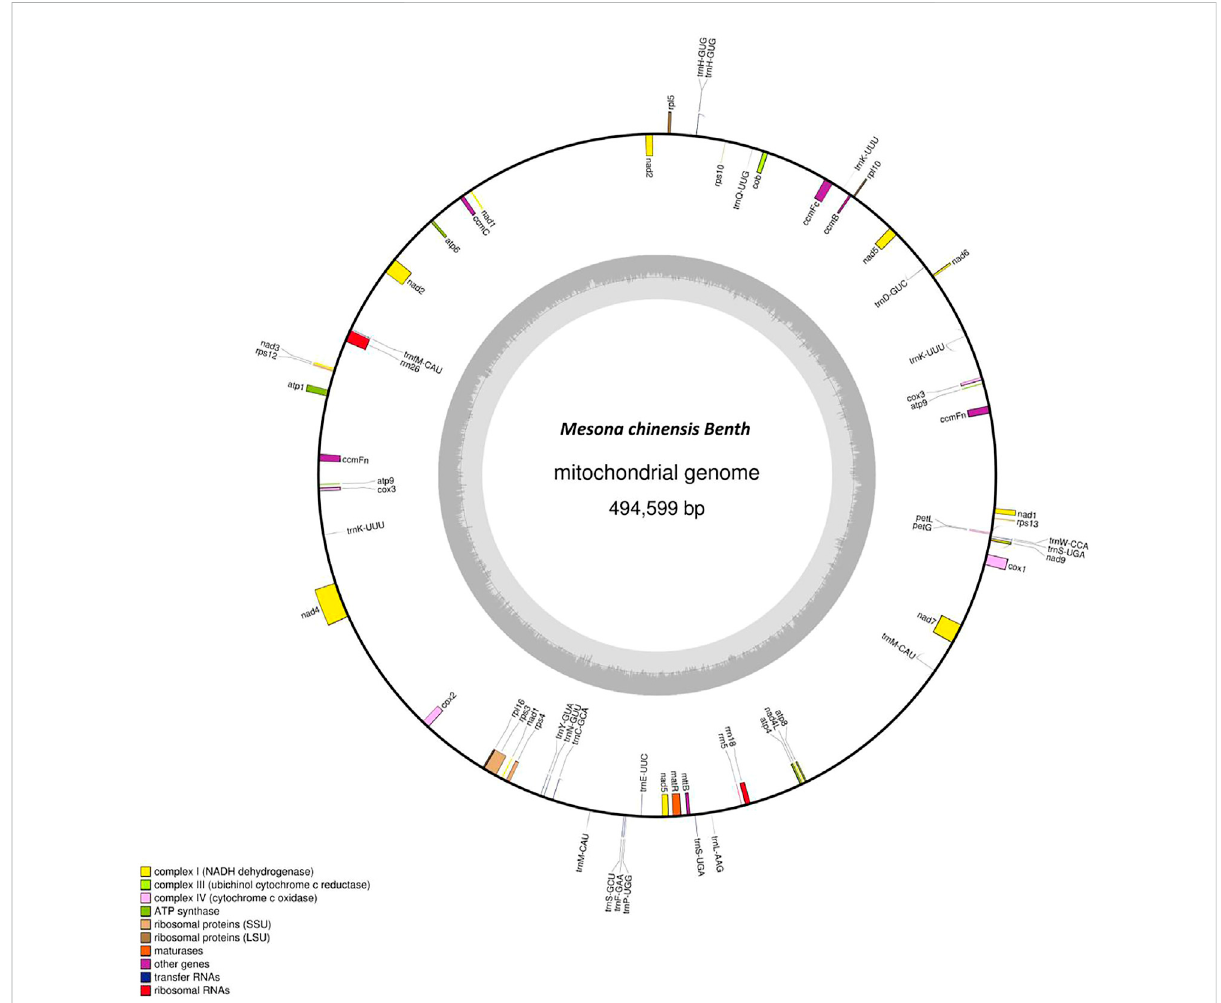
FIGURE 1 The circular mitochondrial genome of Mesona chinensis Benth (MCB). Genes shown outside of the circle are transcribed clockwise, whereas genes on the inside are transcribed counterclockwise. Genes belonging to different functional groups are color-coded. GC content is represented on the inner circle by the dark gray